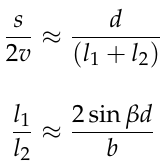
where d is the field of view, l 1 is the distance between the prism and the object set, l 2 is the distance between the prism and the lens set. In the current manuscript, the d = 100 mm, so the l 1 + l 2 is about 300 mm and l 1 is about 200 mm, and l 2 is about 100 mm. A conventional five-parameter distortion model is used in this work. It consists of three radial and two tangential distortion parameters. The prism and the camera lens are treated as a lens set. We assume that the conventional distortion model can correct the overall distortion. The distortion calibration plot of the single-camera four-view 3D-DIC system is shown in Figure 9.